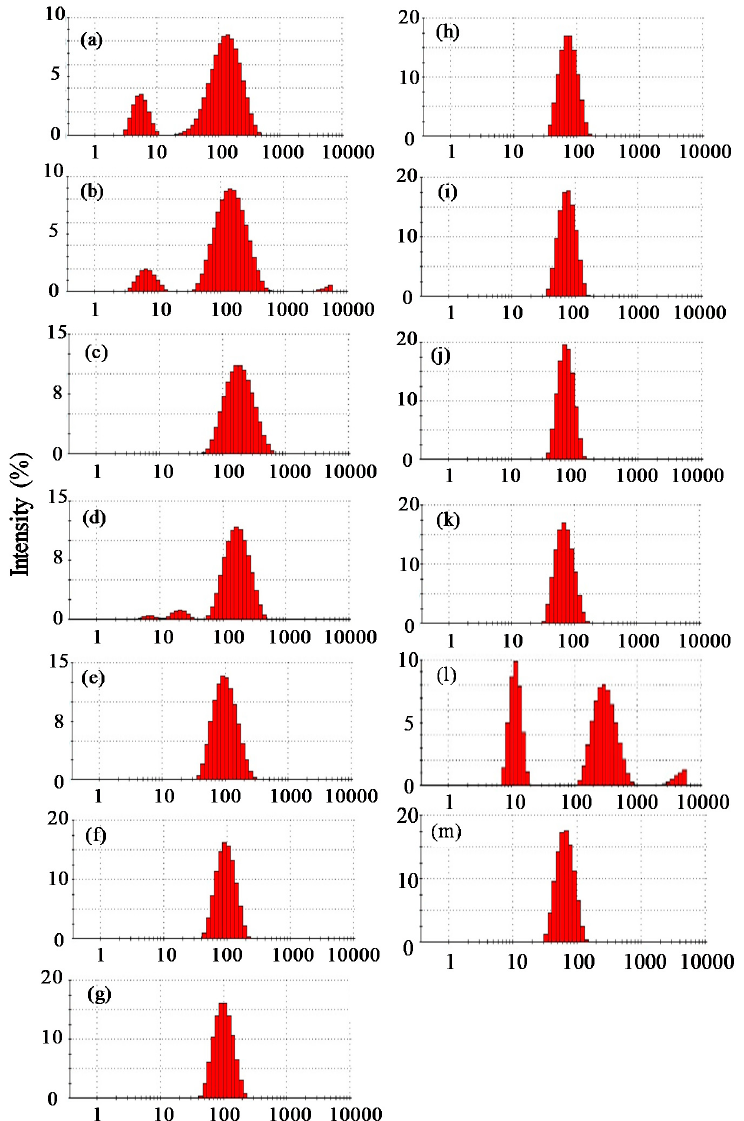
Figure 2. Relationship between Particle diameter in the di ff erence of mixing weight ratio of DSPE-PEG2000 and Soluplus, ( a ) DSPE-PEG2000 / Soluplus = 10 / 1, ( b ) DSPE-PEG2000 / Soluplus = 5 / 1, ( c ) DSPE-PEG2000 / Soluplus = 4 / 1, ( d ) DSPE-PEG2000 / Soluplus = 3 / 1, ( e ) DSPE-PEG2000 / Soluplus = 2 / 1, ( f ) DSPE-PEG2000 / Soluplus = 1 / 1, ( g ) DSPE-PEG2000 / Soluplus = 1 / 2, ( h ) DSPE-PEG2000 / Soluplus = 1 / 3, ( i ) DSPE-PEG2000 / Soluplus = 1 / 4, ( j ) DSPE-PEG2000 / Soluplus = 1 / 5, ( k ) DSPE-PEG2000 / Soluplus = 1 / 10, ( l ) only DSPE-PEG2000, ( m ) only Soluplus.